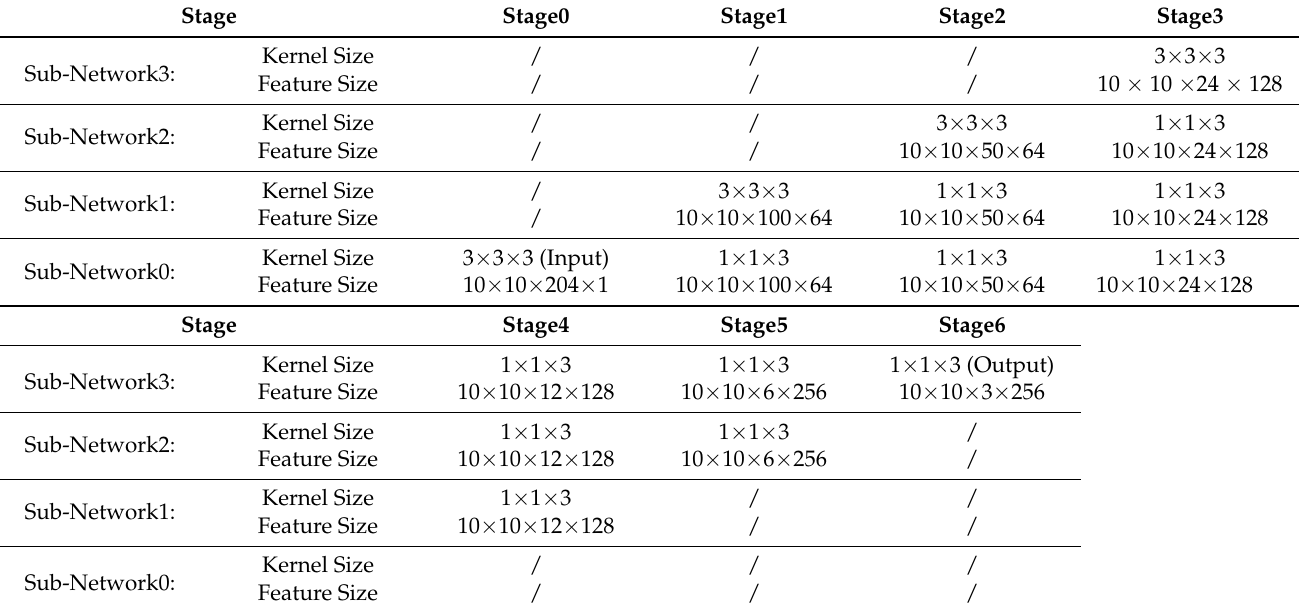
Table 4. Network framework